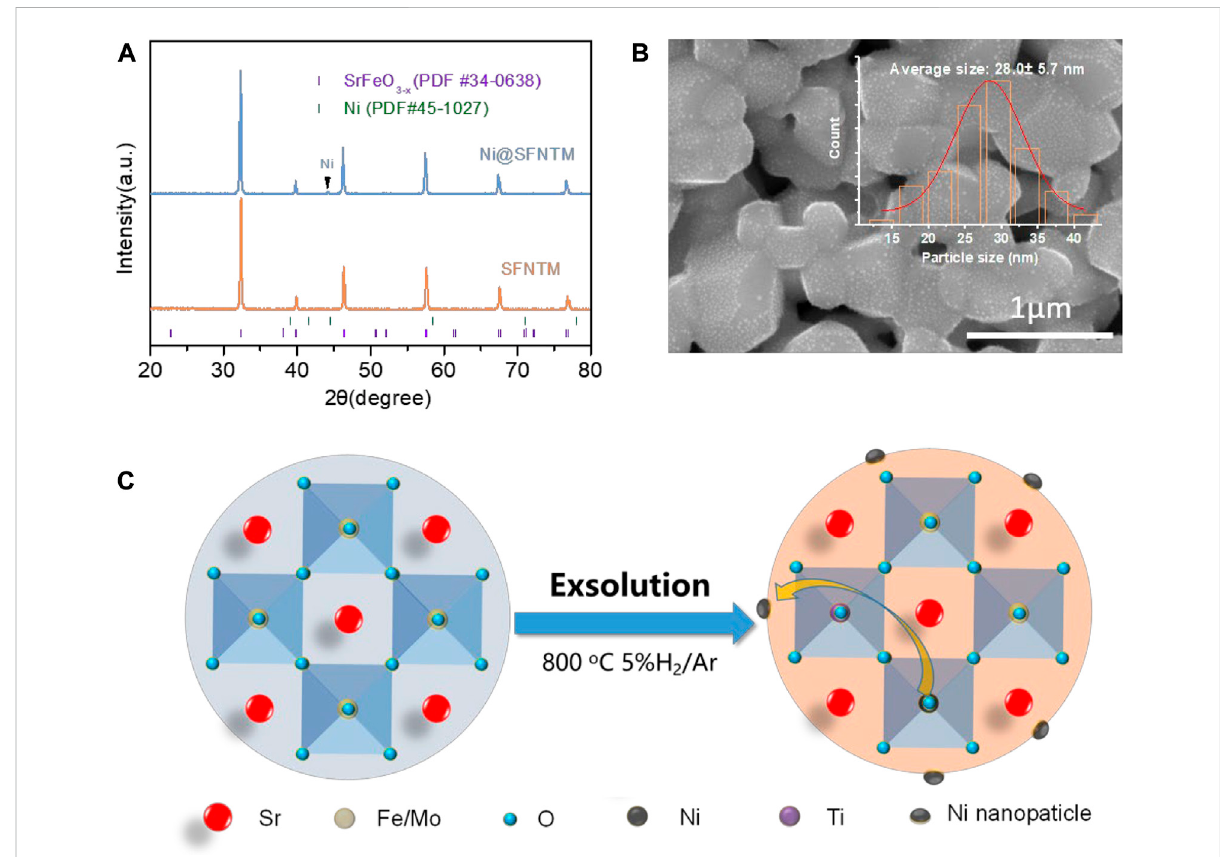
FIGURE 1 (A) XRD patterns of SFTM and Ni@SFNTM powders, (B) SEM image of Ni@SFNTM, inset is particle size distribution of Ni nanoparticles, (C) Schematic diagram of in situ exsolution of SFNTM under reducing